Question: Reading the figure, is the described quantity rising or falling?
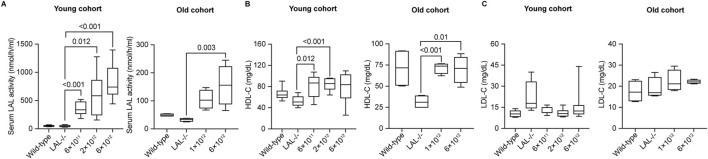
Answer: increasing